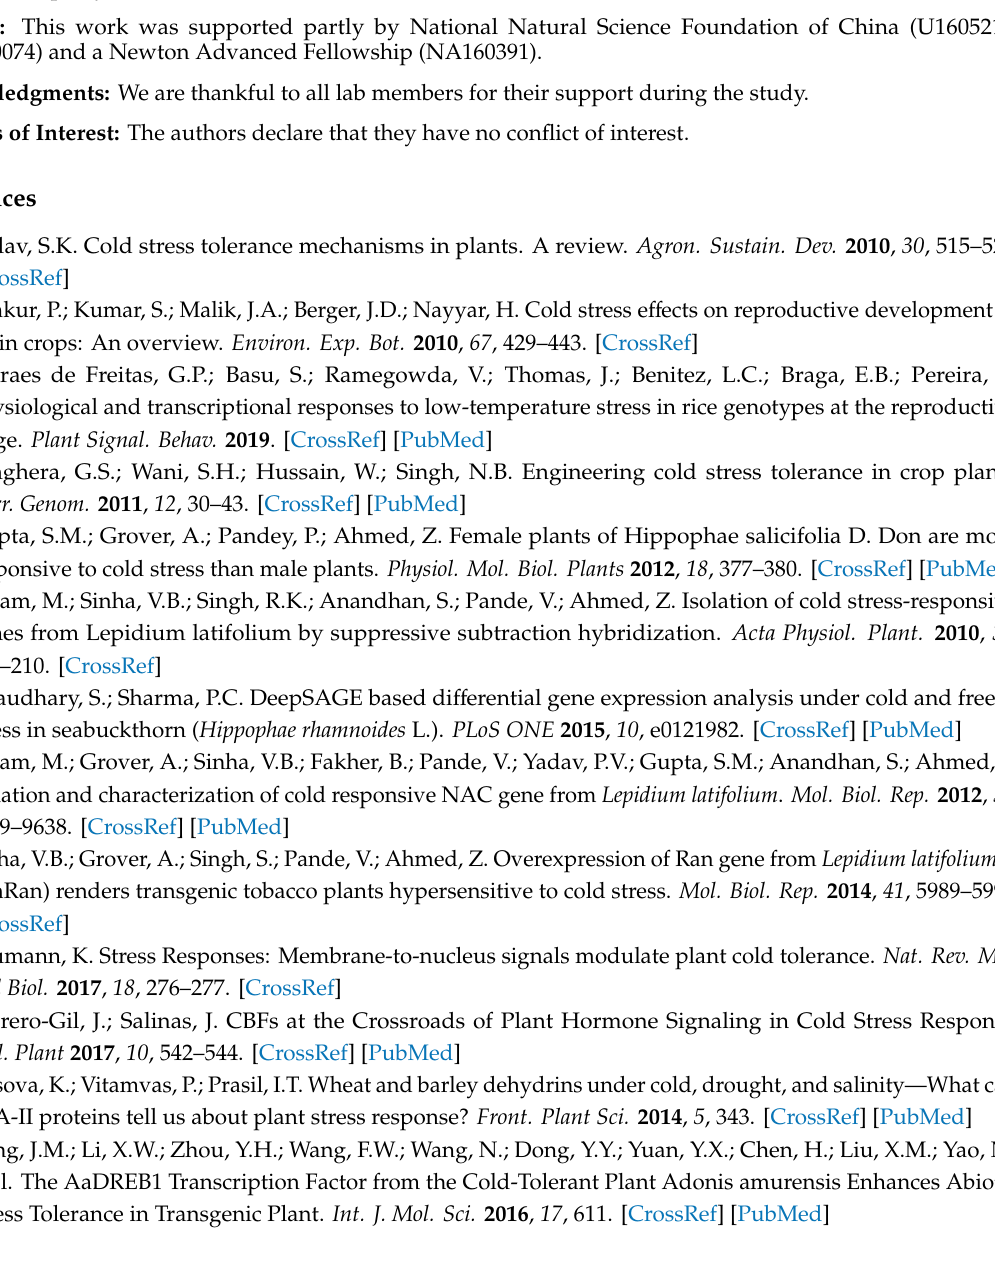
Table S1: List of primers used in the study, Figure S1: Secondary structure of LlaCIPK protein, Figure S2: pBinAR-CIPK vector